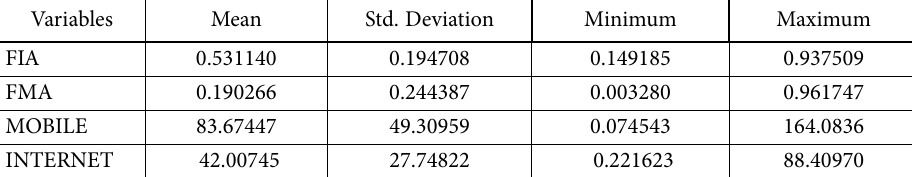
Table 2. Summary statistics of the